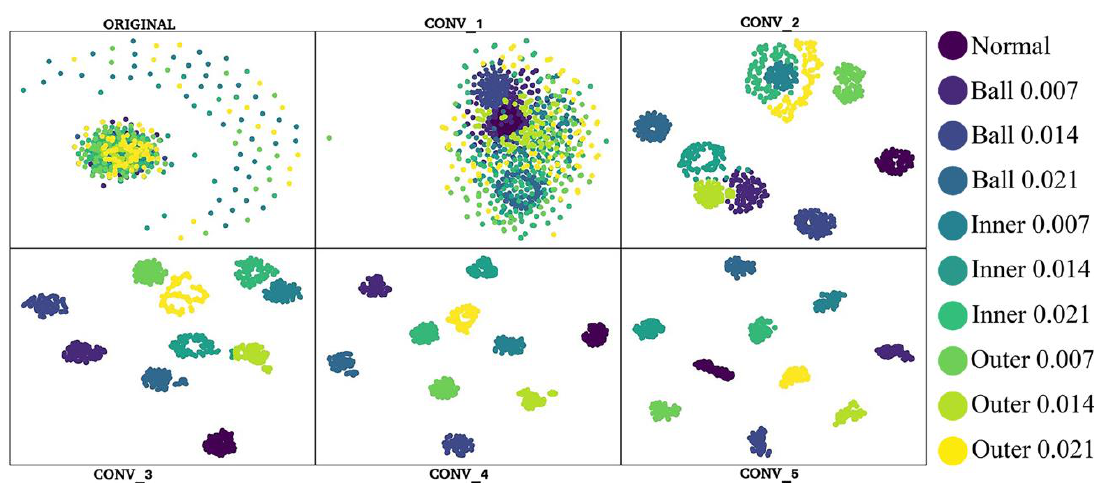
Figure 10. Feature distribution corresponding to the number of iterations.